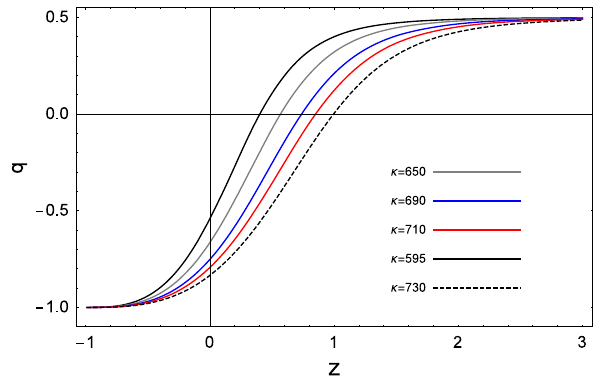
Fig. 1 The behavior of deceleration parameter for C 2 = 0 . 3025, (cid:8) 0 = 0 . 315 (the current value of (cid:8) m